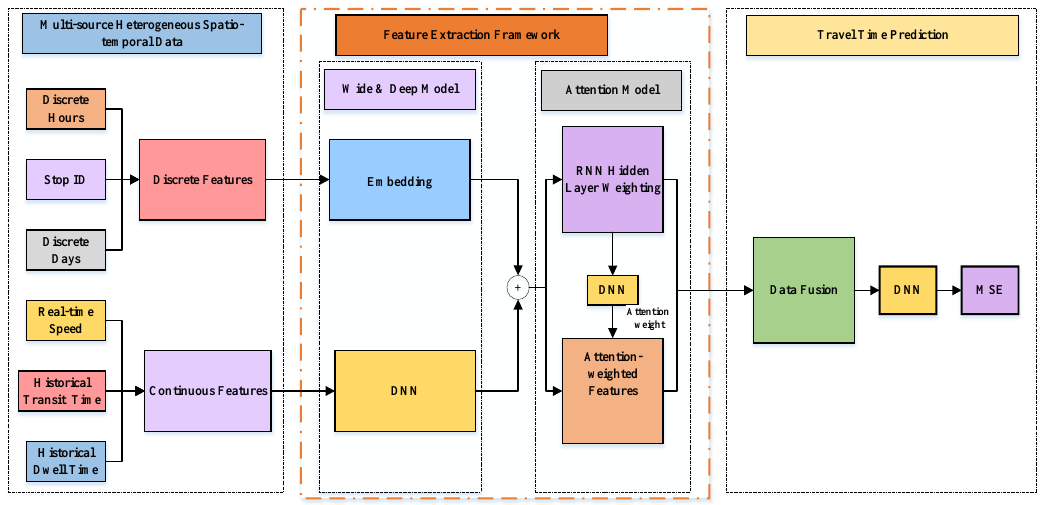
Figure 6. Overview of the model developed for the bus dynamic travel time prediction.